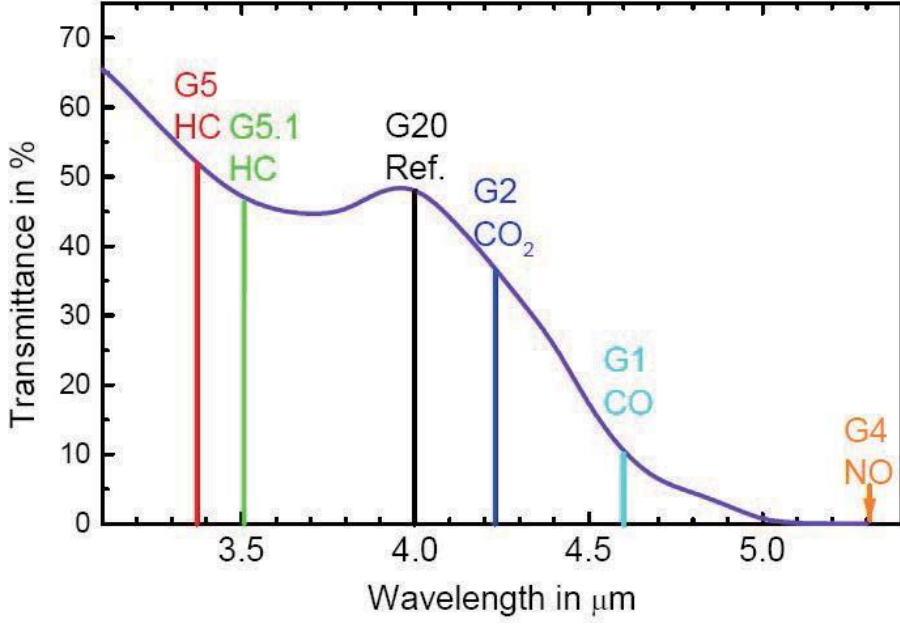
Figure 6. Transmittance of the lamp at the